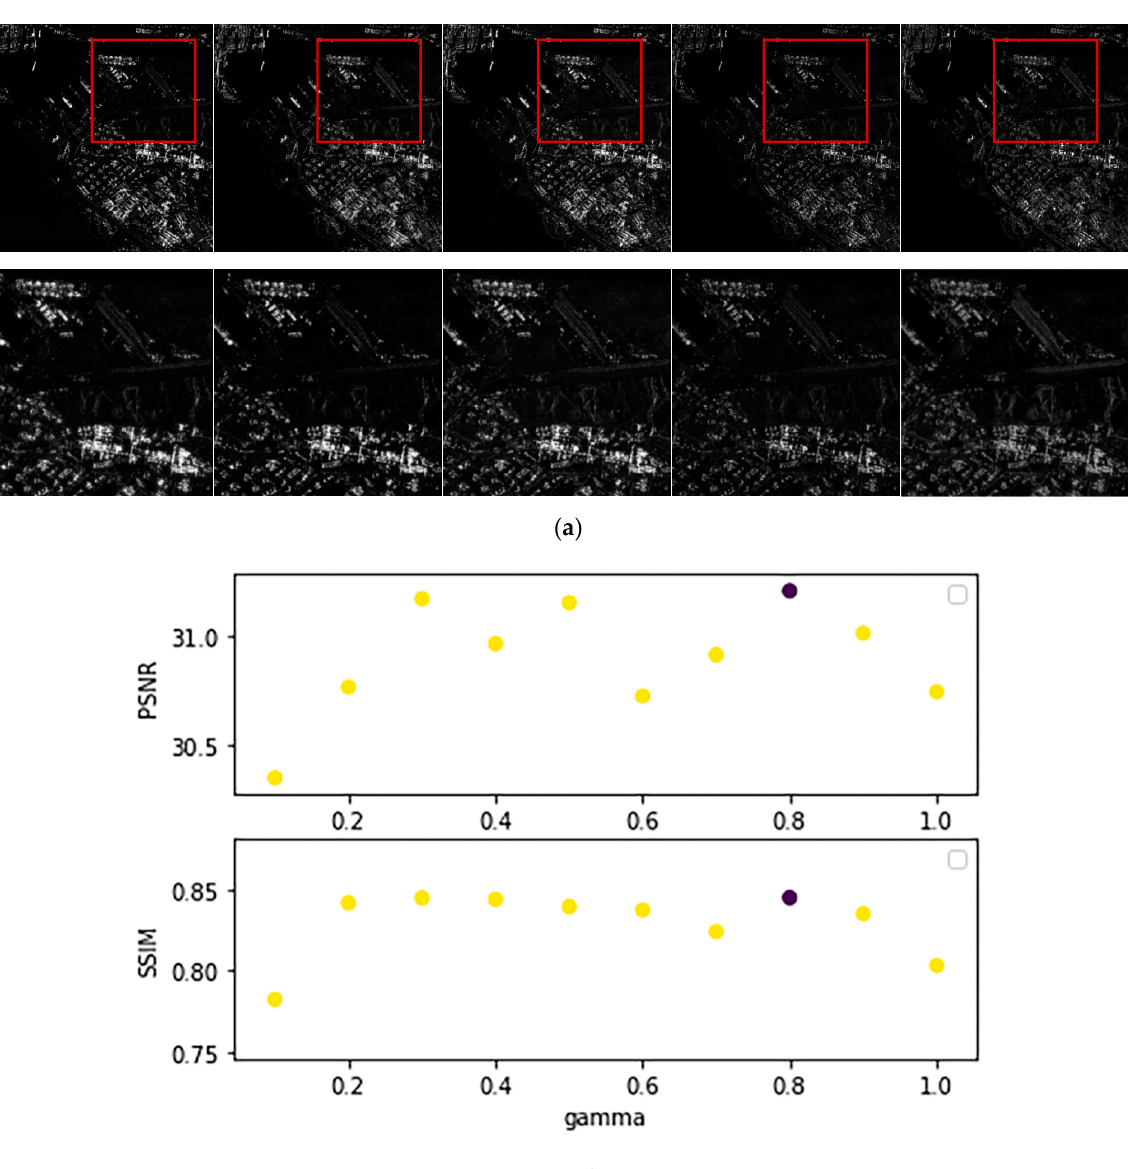
Figure 11. Evaluation of different gamma values. ( a ) Visual results under gamma values of 1, 0.9, 0.8, 0.7, 0.6. ( b )Numerical results under gamma values from 0.1 to 1, with interval of 0.1.